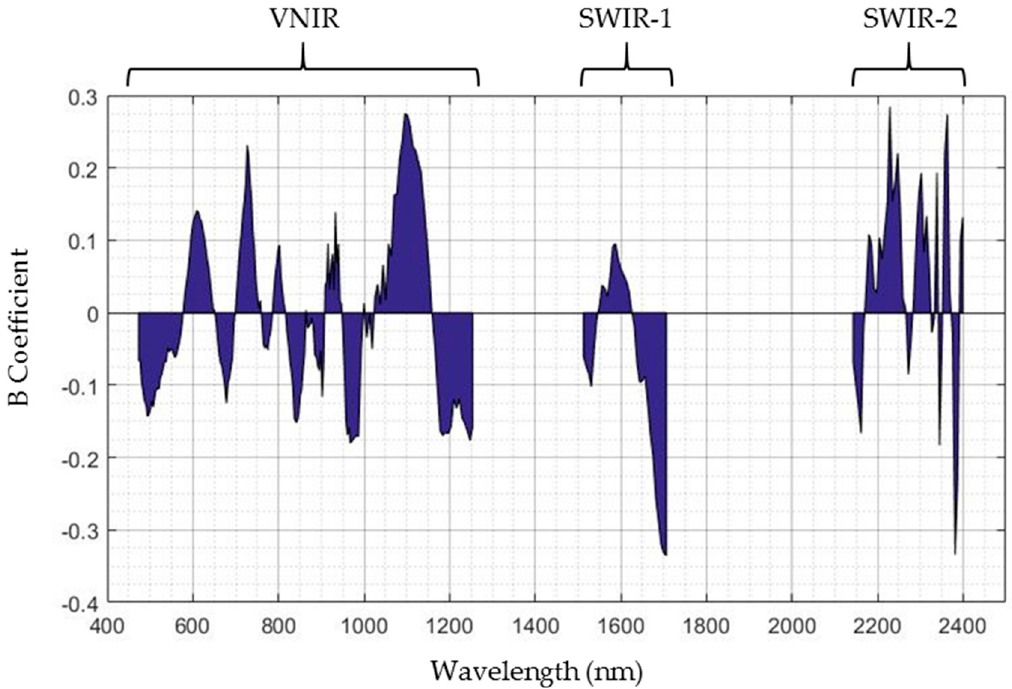
Figure 5. Beta coefficient spectrum representing the band weight in the model. Table 3. Possible spectral assignments.